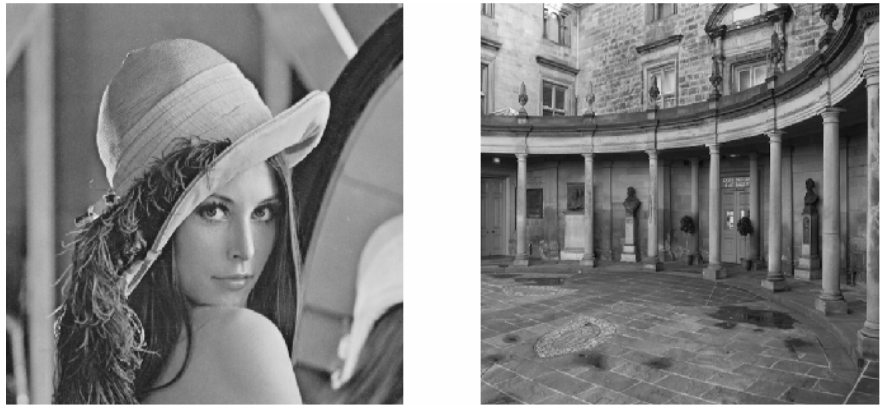
Figure 5. Sample images used in the test. On the left, the image A (“Lena”); on the right the image B (from dataset [58]).